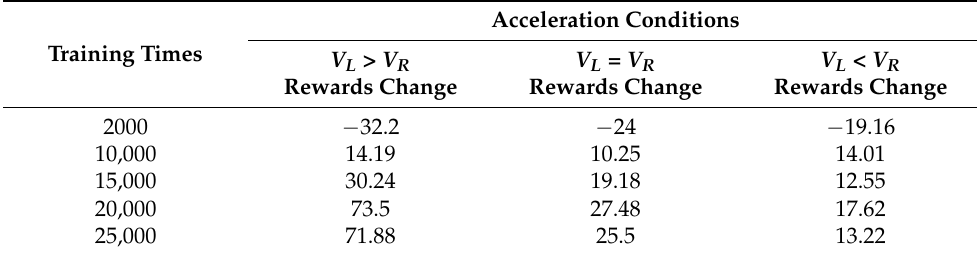
Table 2. Variation of reward function values under different acceleration conditions between two sides of the detection–interference confrontation.